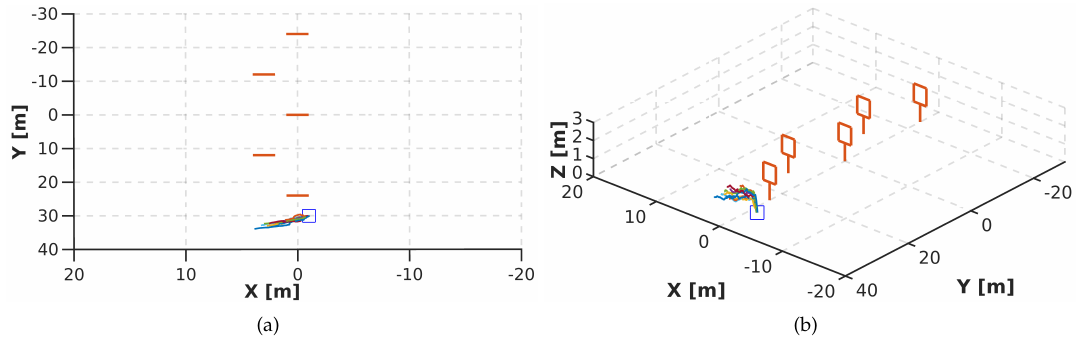
Figure 17. Top view ( a ) and side view ( b ) of the performance of PoseNet, trained to predict the 4 flight commands, for 10 runs in the zigzag racetrack. Note that PoseNet failed to cross the first gate in all runs. We used a mosaic image composed of 6 frames as image input to the network.